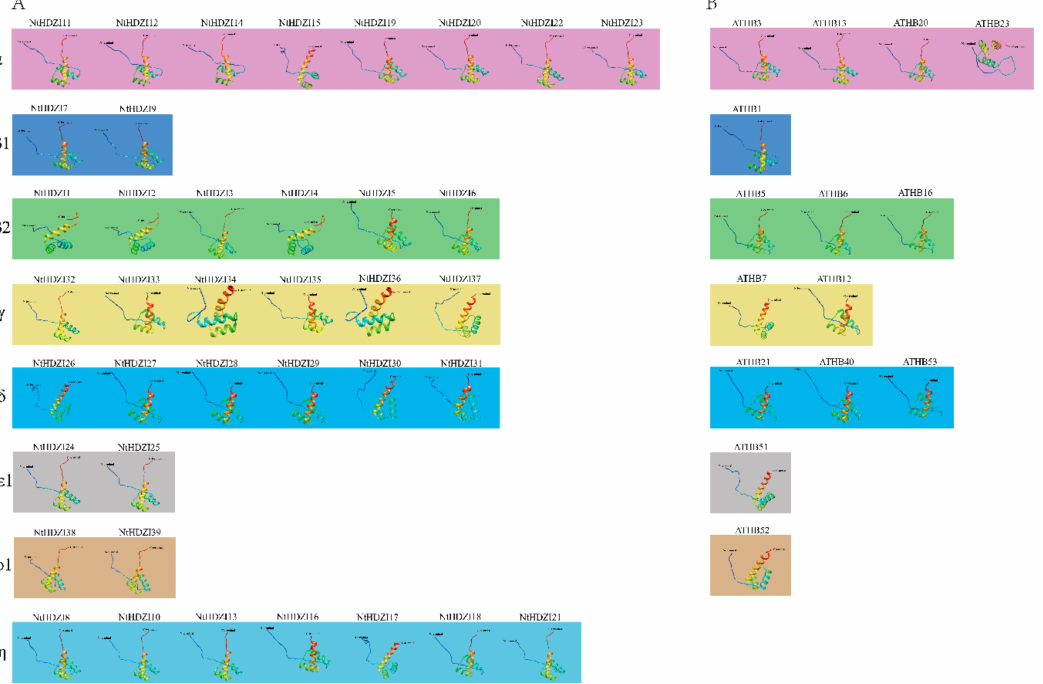
Figure 3. Three-dimensional modeling of HD-Zip I proteins in N. tabacum and Arabidopsis. The structure of NtHDZI proteins ( A ) and ATHBI proteins ( B ), with a confidence level > 90%, is shown and the activated sites are highlighted in light blue, yellow, and light green.